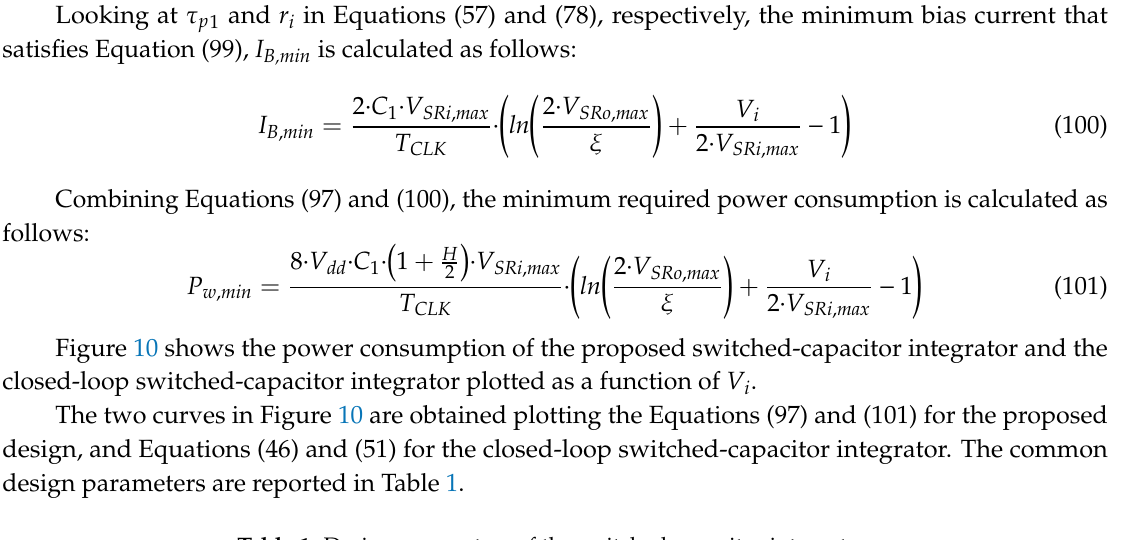
Table 1. Design parameters of the switched capacitor integrator.